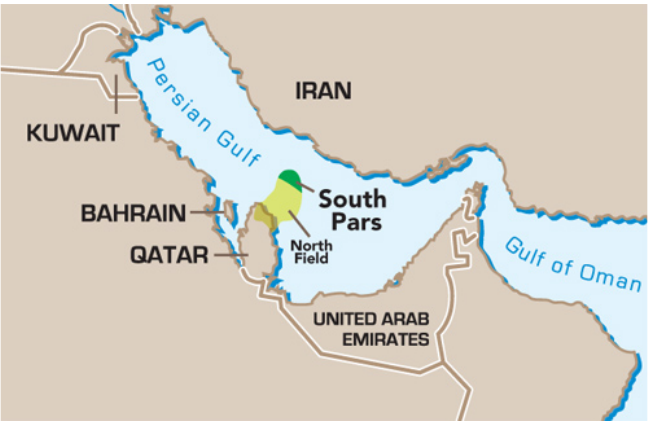
Figure 1. South Pars Gas Field of